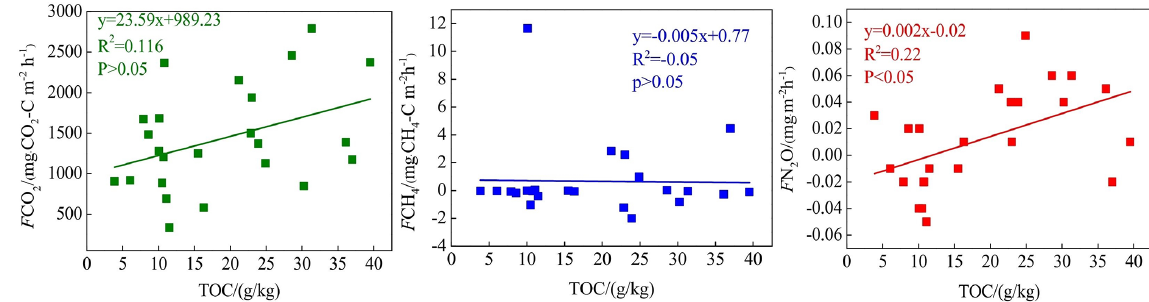
Figure 8. Correlations between soil organic carbon (TOC) content and GHG emission ( F ). Table 4. Correlations between CO 2 , CH 4 , and N 2 O emissions and impact factors ( n = 62). GHG flux ST10 ST20 SMC10 SMC20 TOC ρ b C : N pH EC BIO CO 2 0.634 b 0.592 b 0.307 a 0.216 0.393 − 0 . 463 b − 0 . 289 b CH